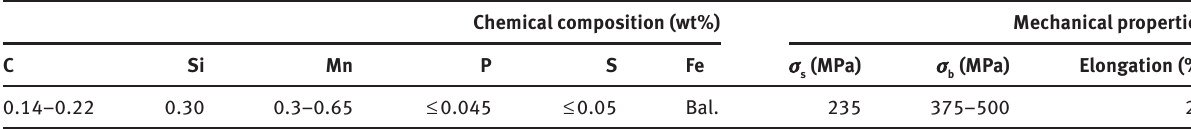
Table 1: Chemical composition and mechanical properties of Q235